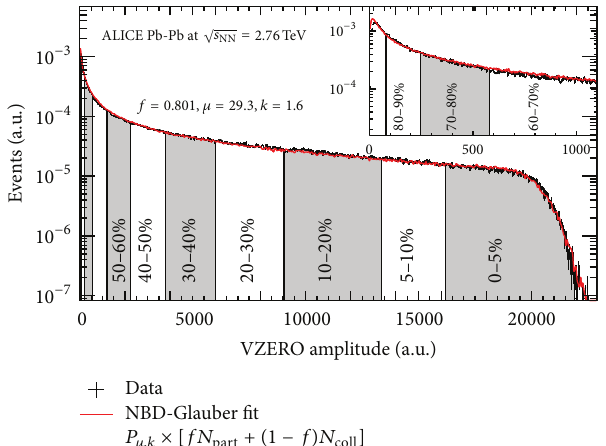
Figure 1: Distribution of the summed amplitudes in the VZERO scintillator tiles (histogram); inset shows the low amplitude part of the distribution. The curve shows the result of the Glauber model fit to the measurement. The vertical lines separate the centrality classes used in the analysis, which in total correspond to the most central 80 % of hadronic collisions. The figure is taken from [21].